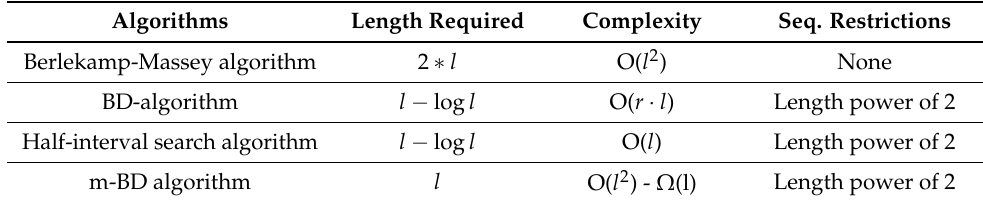
Table 5. Algorithm comparison.